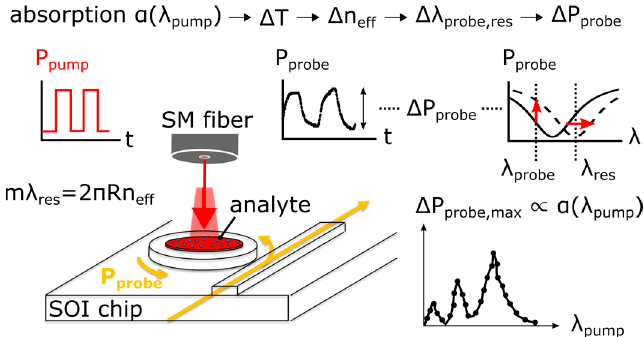
Figure 15. Schematic of the photo-thermal sensing principle. A modulated mid-infrared pump beam is absorbed by the analyte which causes a local temperature change of the microring waveguide. The thermo-optic effect changes the effective index of the waveguide mode, hereby changing the resonance wavelength λ res of the microring. For a given fixed probe wavelength λ probe , the change in λ res produces a change in probe power Δ P probe which is measured using a near-infrared detector. The absorption spectrum of the analyte can be reconstructed by scanning the pump wavelength and recording the maximum probe modulation Δ P probe,max .